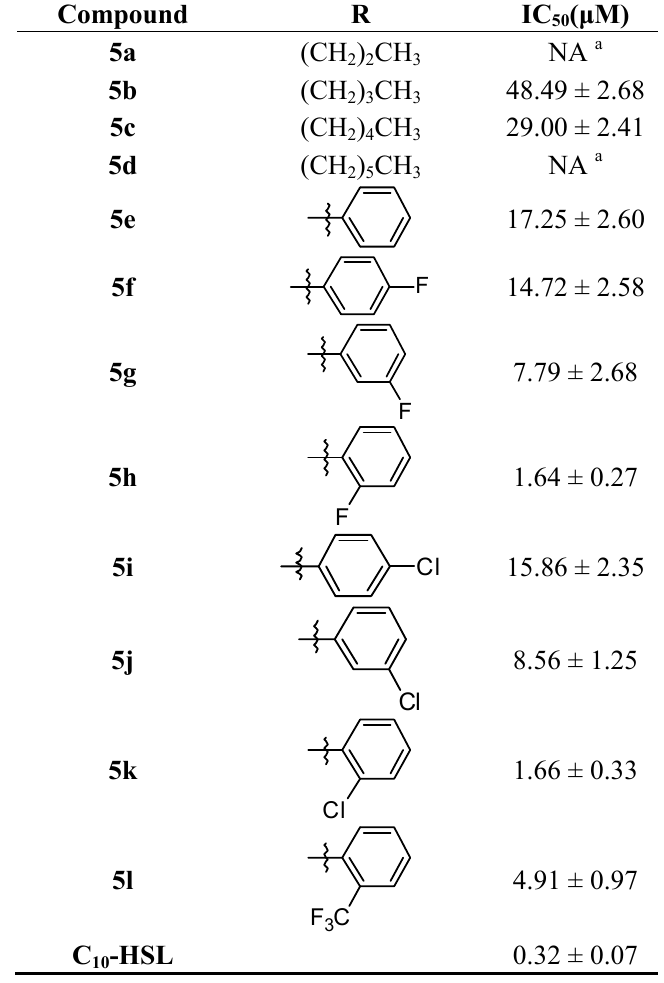
Table 1. The substituents and IC